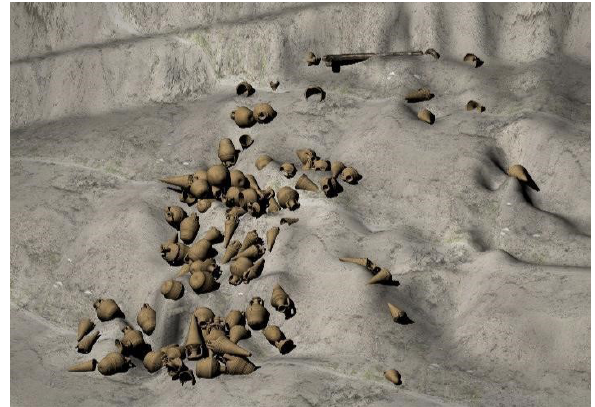
Figure 15. Textured polygonal model.